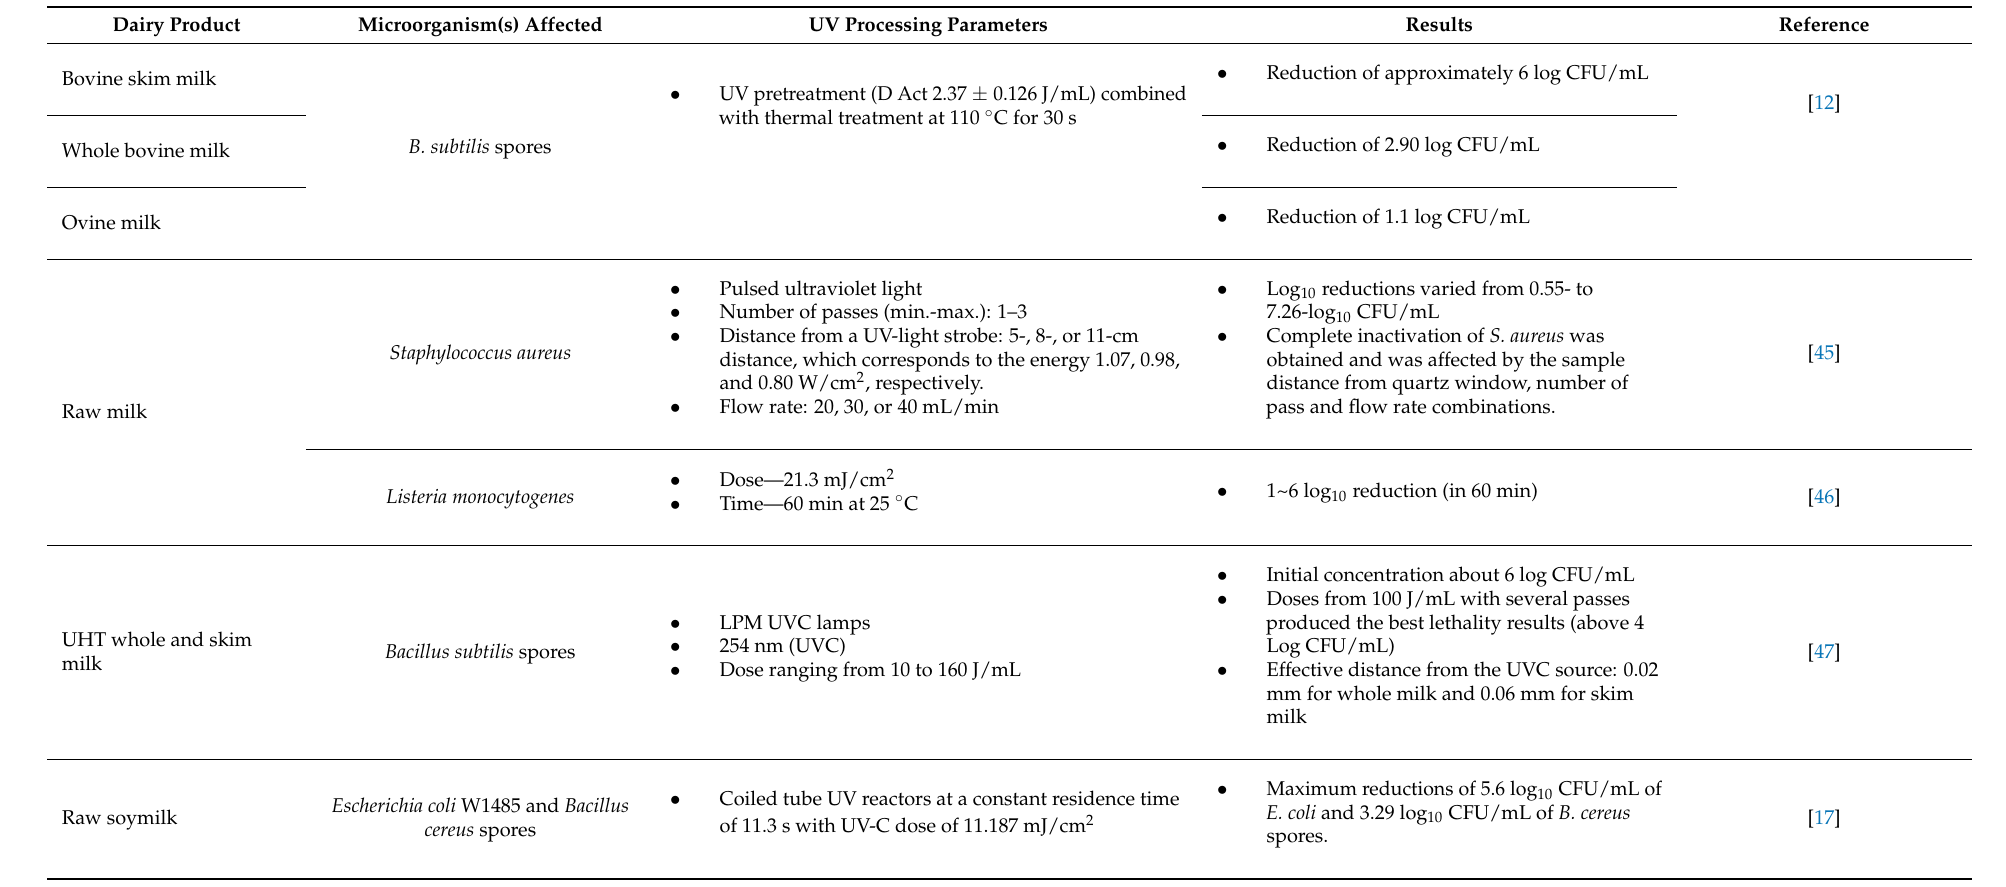
Table 2. Impact of ultraviolet radiation technology on the microbial inactivation of dairy